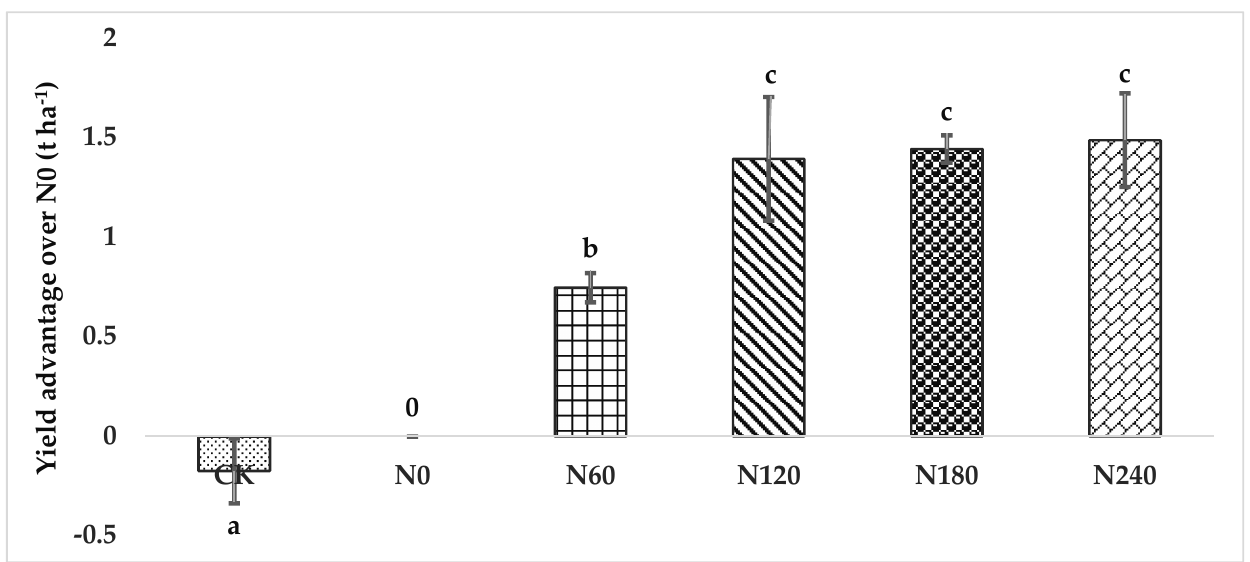
Figure 4. Grain yield produced by different treatments as influenced by Nitrogen doses. CK; control treatment, N0; 0 kg ha −1 N, N60; 60 kg ha −1 N, N120; 120 kg ha −1 N, N180; 180 kg ha −1 N, N240; 240 kg ha −1 N, means with similar letters across the treatments denote a non-significant effect ( p ≤ 0.05).